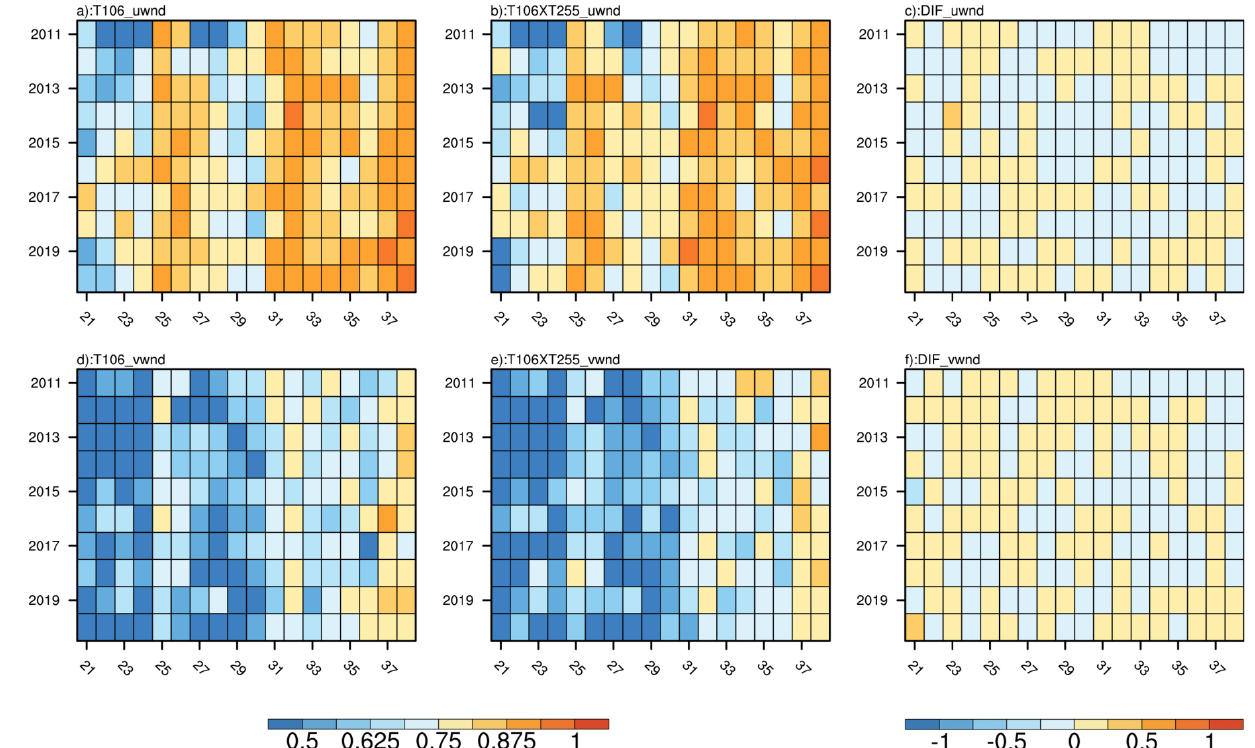
Figure 5. The pattern correlation coefficients between reanalysis and model predictions of ( a , d ) T106 and ( b , e ) T106 × T255 for ( a – c ) zonal wind and ( d – f ) meridional wind at 850 hPa over the SCSSM region (20° S − 30° N, 60° − 150° E) for 2011–2020 (y − axis) from the 21st pentad to the 38th pentad (x − axis) for lead times of 1–31 days. The differences in pattern correlation coefficients in the two models are presented in ( c , f ).